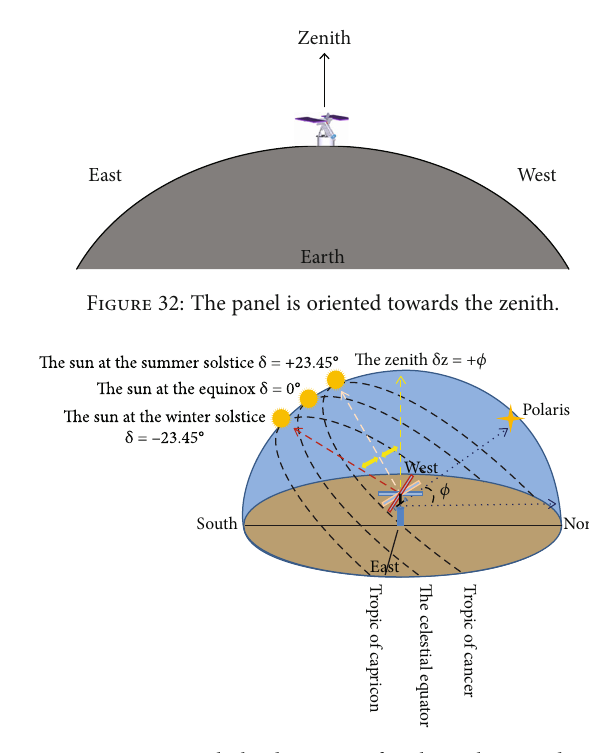
Figure 33: Panel tilt adjustment after the parking